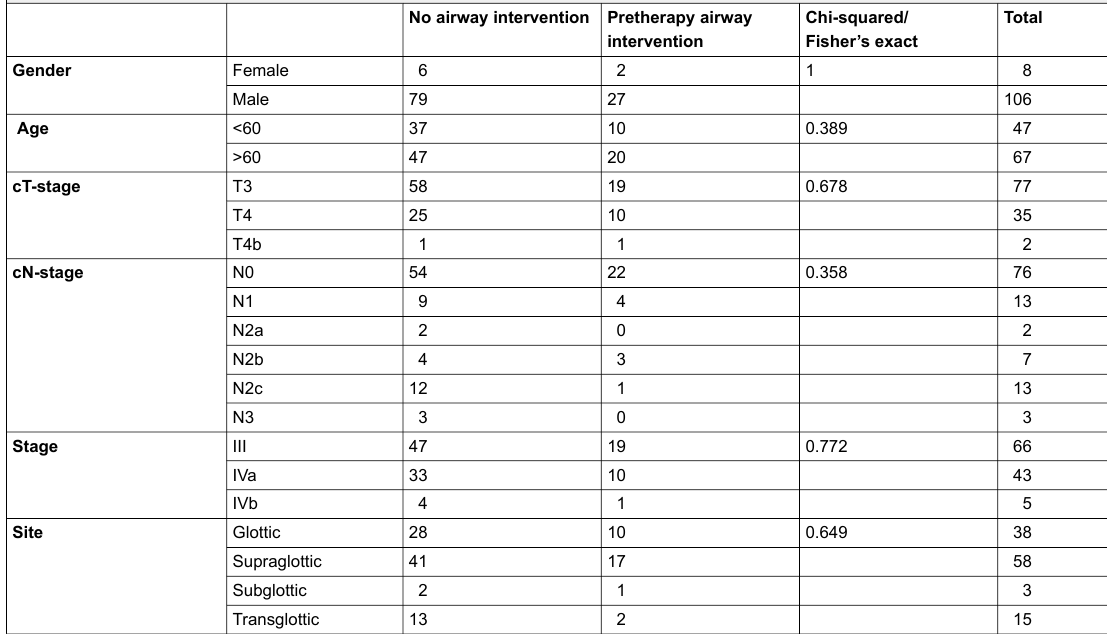
Table 1: Comparison of patients and disease characteristics between intervention and non-intervention